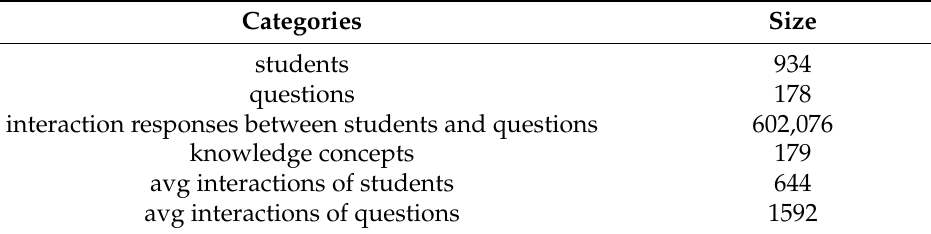
Table 3. Dataset statistics of